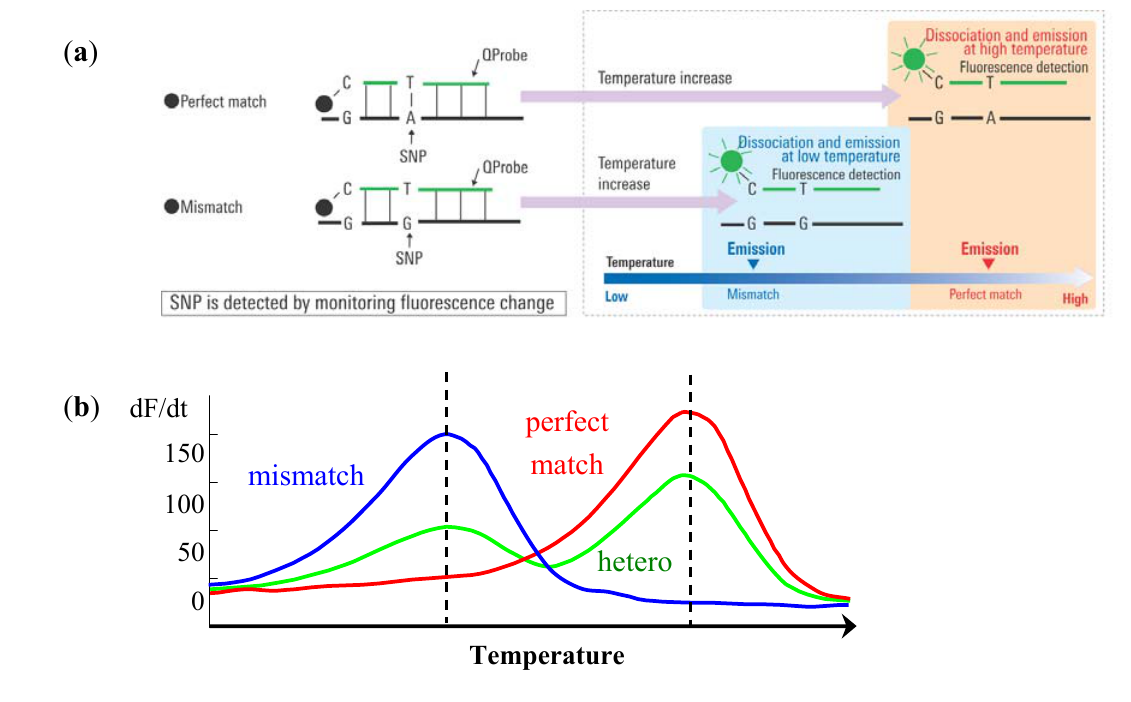
Figure 1. Measurement principle—Quenching Probe (QProbe). ( a ) QProbe quenches when hybridizing to the target nucleic acid. By detecting the change of fluorescence, it is possible to detect the existence of the target sequence. ( b ) A typical detection result using